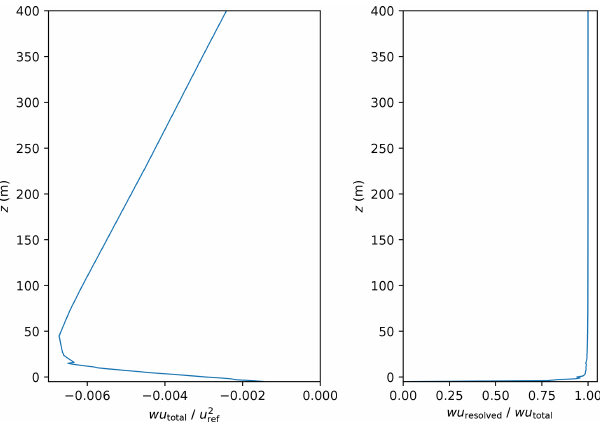
Figure 6. Mean profile of the vertical momentum flux and the ratio between resolved and total flux, averaged over the entire domain of the PALM simulation. Please note the two different horizontal scales for momentum flux (bottom scale) and flux ratio (top